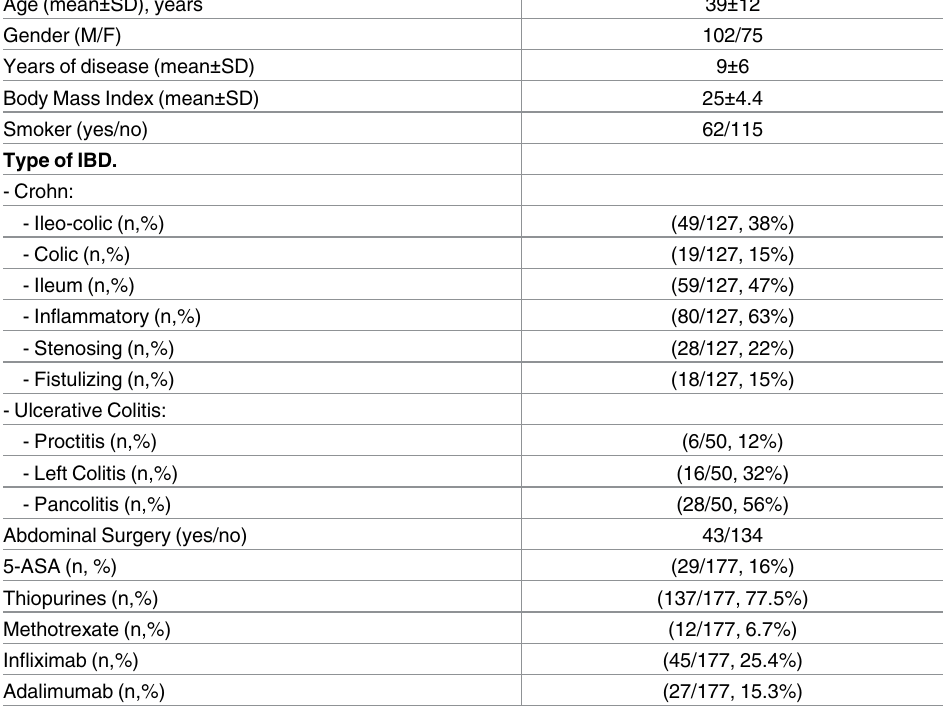
Table 1. Demographic data of the